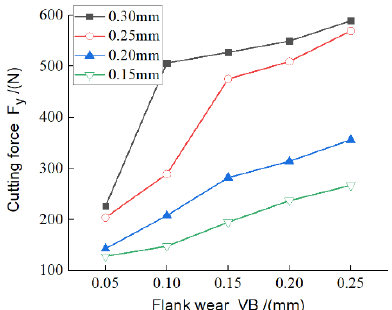
Figure 4. E ff ect of chamfer width on cutting force under di ff erent tool wear. Figure 4. Effect of chamfer width on cutting force under different tool wear. Figure 4. Effect of chamfer width on cutting force under different tool wear.